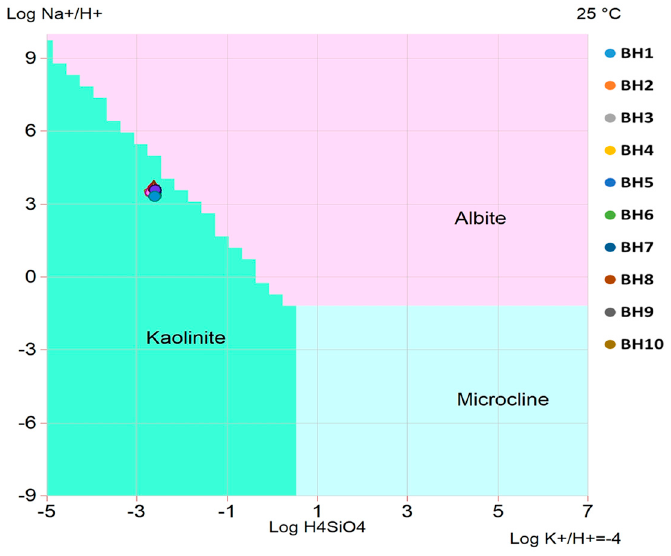
Figure 8. The Korjinski diagram showing the position of water samples in relation to various minerals phases.